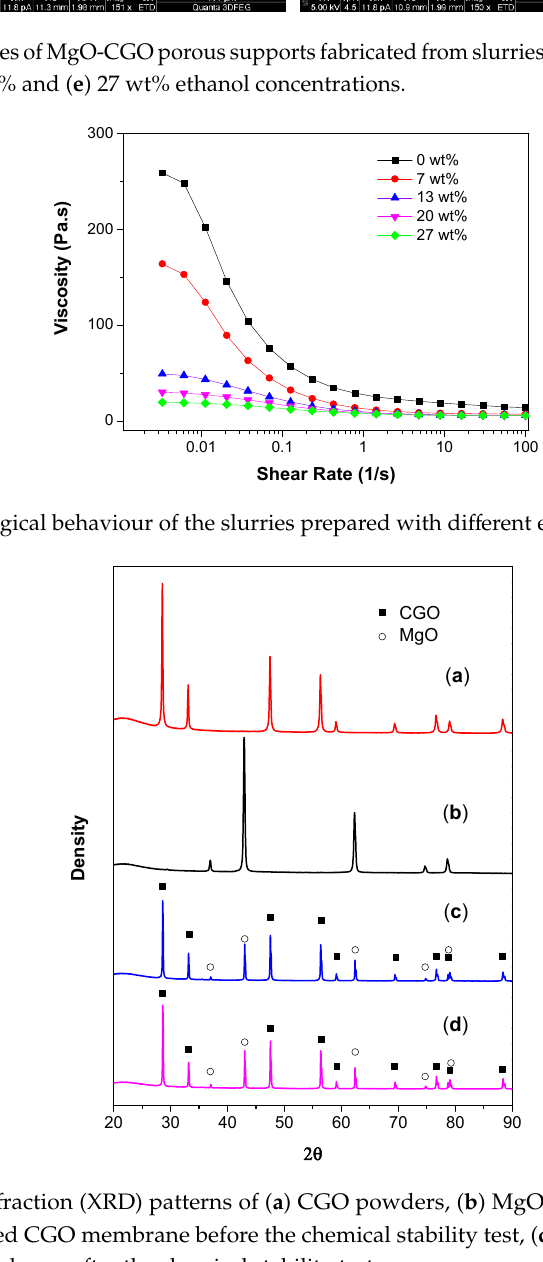
Figure 17. X-ray diffraction (XRD) patterns of (a) CGO powders, (b) MgO powders, (c) CGO-MgO dual-phase supported CGO membrane before the chemical stability test, (d) CGO-MgO dual-phase supported CGO membrane after the chemical stability